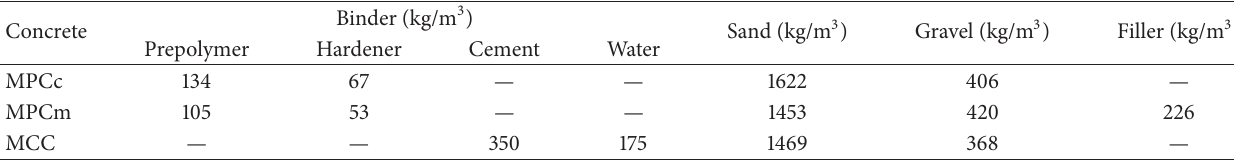
Table 5: Microconcretes mix proportions used in this study.